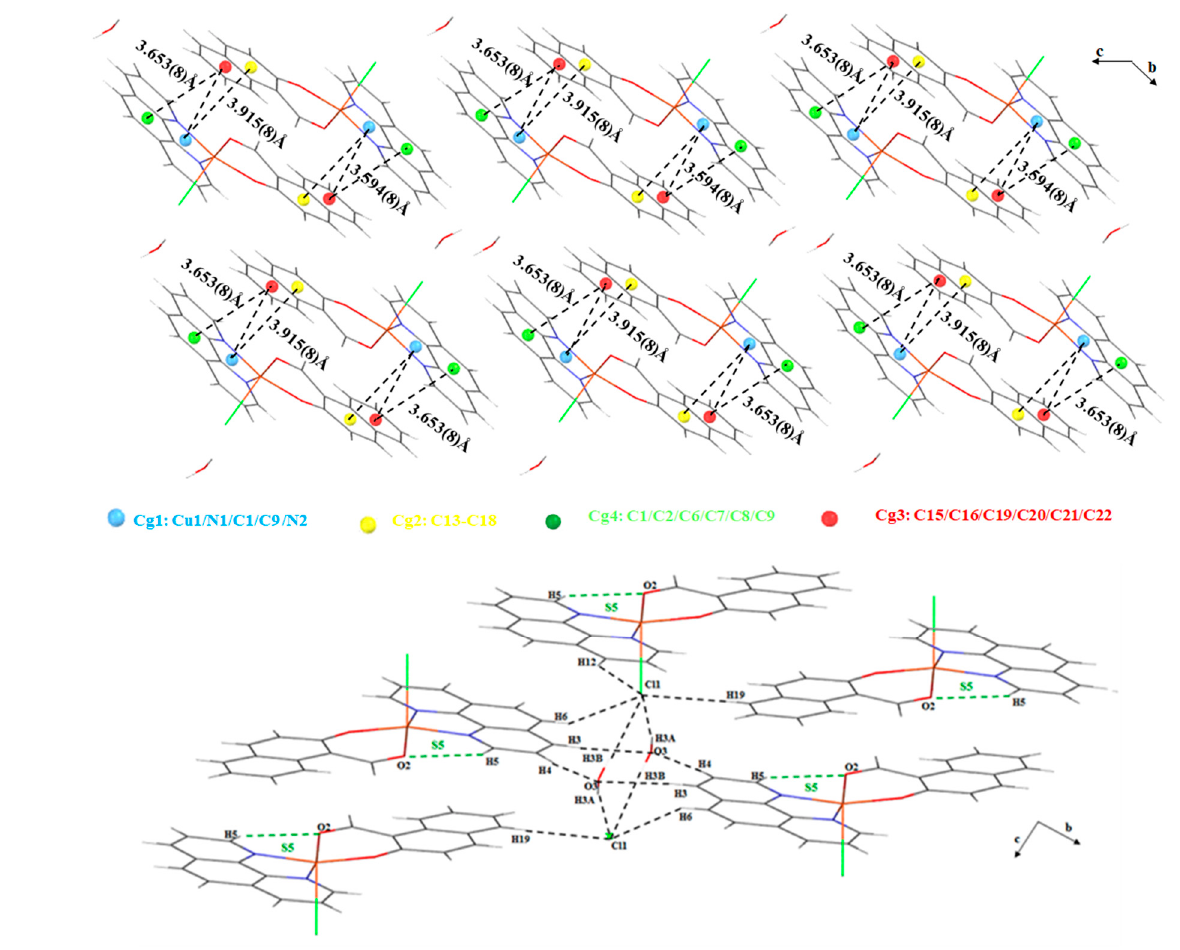
Figure 4. ( a ) Diagram packing of hydrogen bonding, parallel to ( b , c ). Dashed lines (green, black) indicate intra- and intermolecular H-bonds, respectively. ( b ) A view of the aromatic ring organization, with centroid–centroid distances (Å) for C-2.